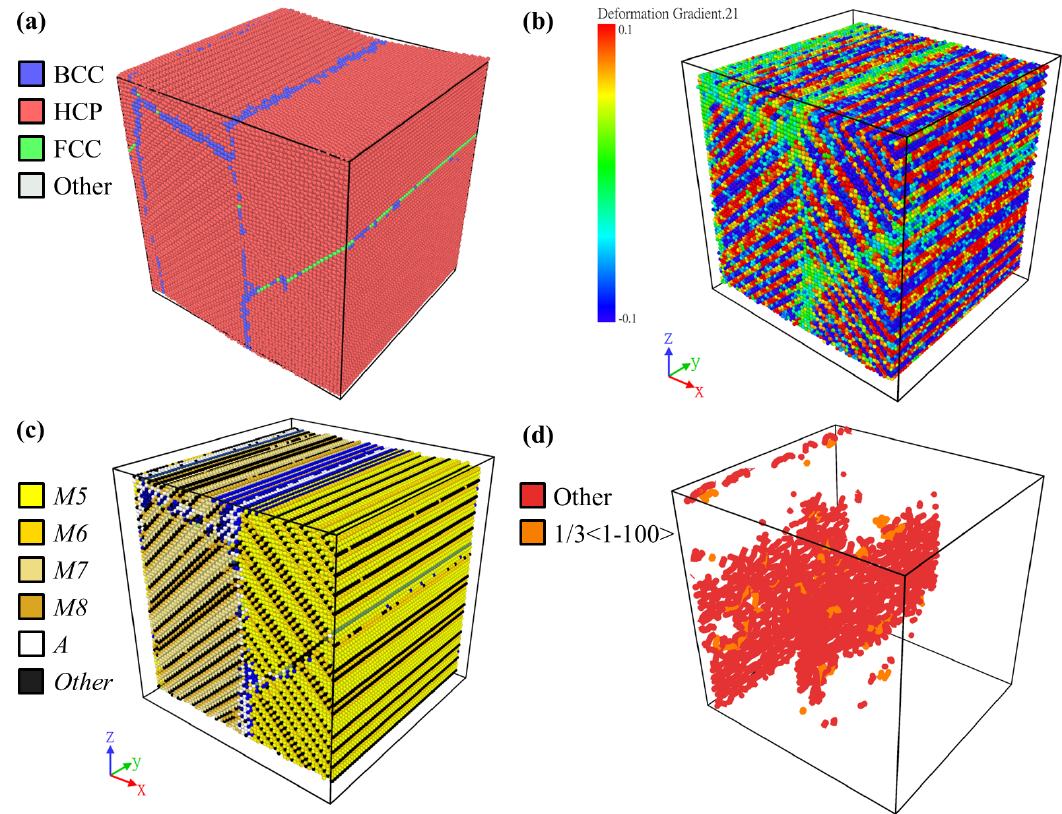
Figure 3. A typical example of the results during the compression tests, analyzed and visualized with ( a ) PTM, ( b ) the deformation gradient, ( c ) the martensite variant identification, and ( d ) DXA (dislocation analysis)